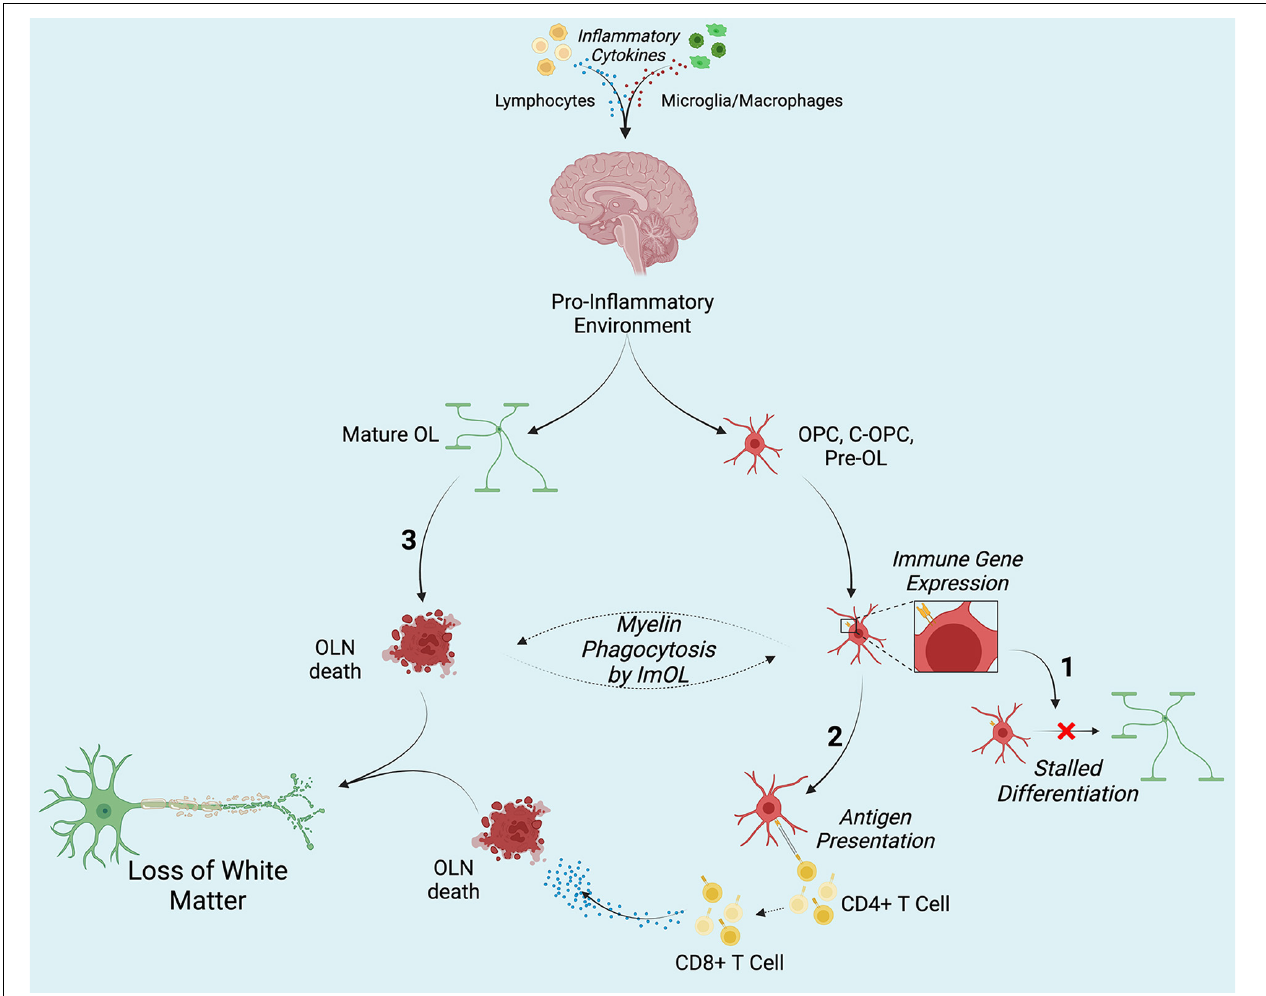
FIGURE 1 | Hypothesized contribution of ImOL to hypo- and de-myelinating disorders and diseases. Secretion of pro-inflammatory cytokines from lymphocytes (and possibly from microglia macrophages) results in the adoption of the immune proteasome by oligodendroglia. (1) Once OLN become ImOL, a host of factors including energy deficits stalls differentiation. (2) Presentation of non-self (MBP, MOG) and self-antigens by ImOL to CD4+ T cells results in the activation of CD8+ T cells which then induce OLN death. (3) Cytokines directly affect Mature OL and cause their death. Together, in no particular order, the three contribute to loss of white matter structures by stopping early stage OLN from differentiation, targeting mature OL (M-OL) and inducing their death, and priming CD8+ T cells toward myelin. Created with